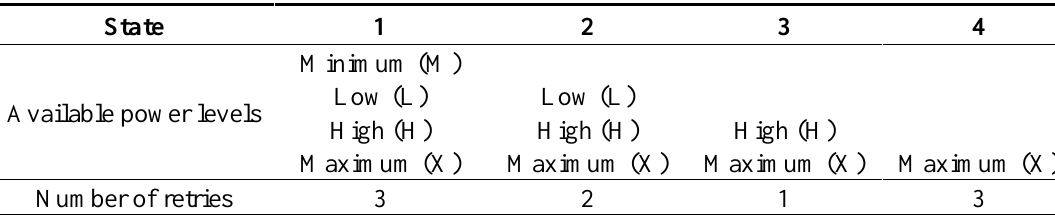
Table 2. States, power levels, and retry